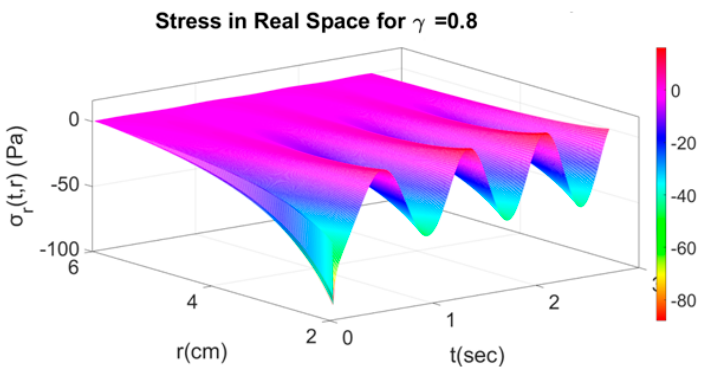
Figure 6. Distribution of the radial stress σ r ( t , r ) in the initial space for γ = 0.8. Similarly, Figure 7 shows the distribution of the radial stress σ θ ( t , r ) in the initial space for γ = 0.8.